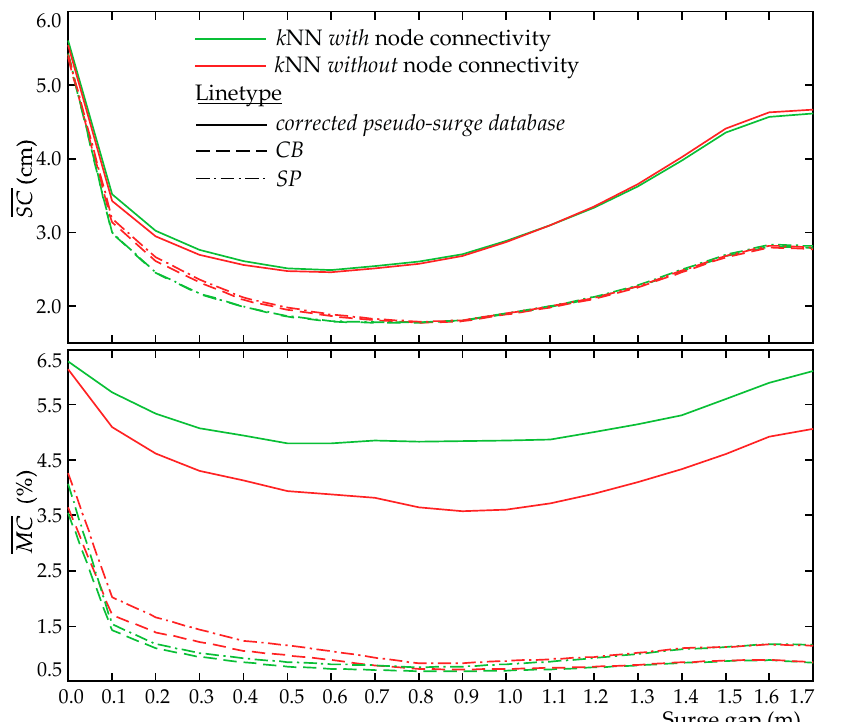
Figure 11. Averaged surge score SC (top row) and misclassification MC (bottom row) validation metrics for different metamodel variants (integrations of the surge and the classification surrogates) for an increasing surge gap. The use of the node grid connectivity or not, as well as the use of the corrected pseudo-surge database or not, are also examined. SC Table 7. Surge score (cm) averaged across different groups of nodes for different surrogate model variants for the implementation that considers different surge metamodels for different classes of nodes.